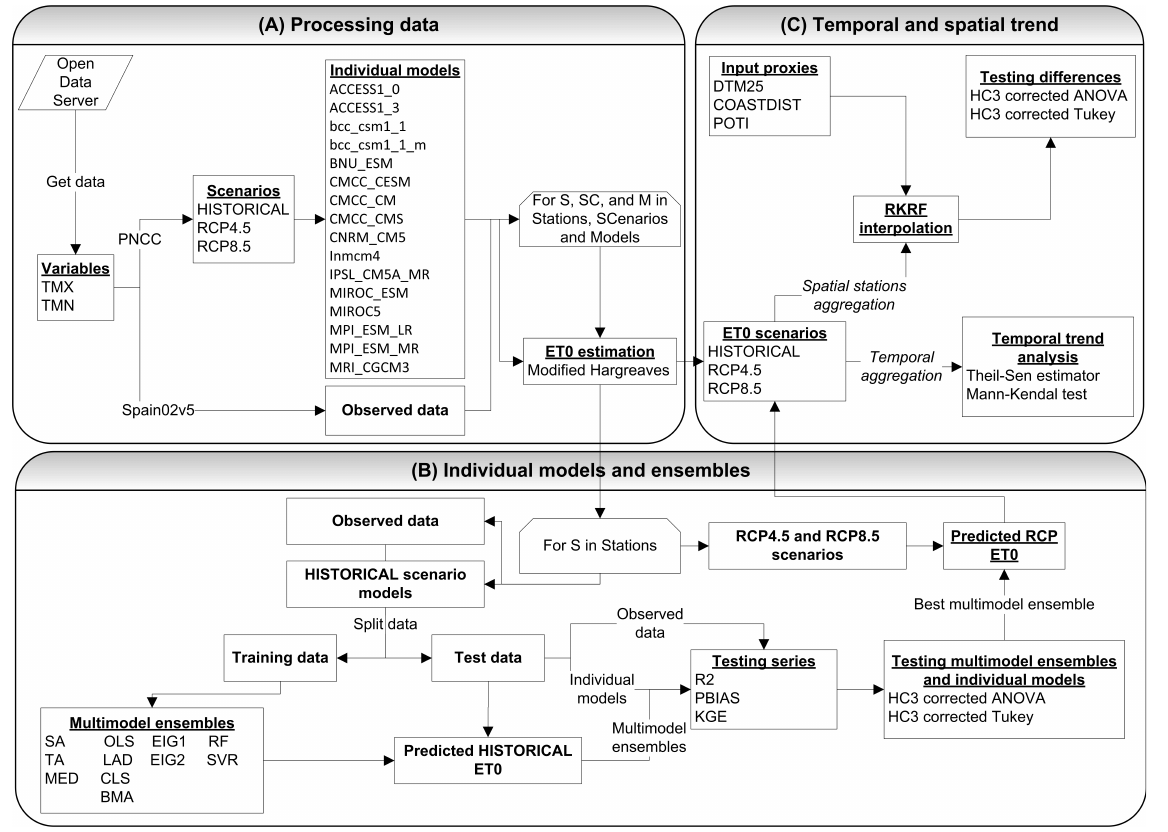
Figure 2. Workflow